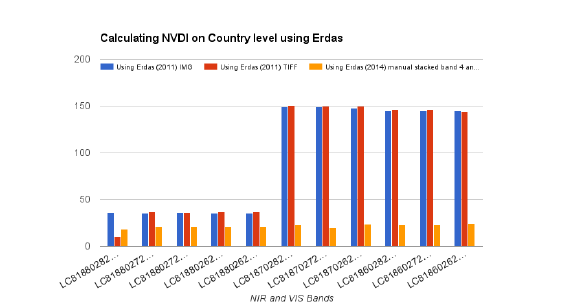
Figure 7: Processing time run by Erdas on TIFF, IMG and Stacked Bands